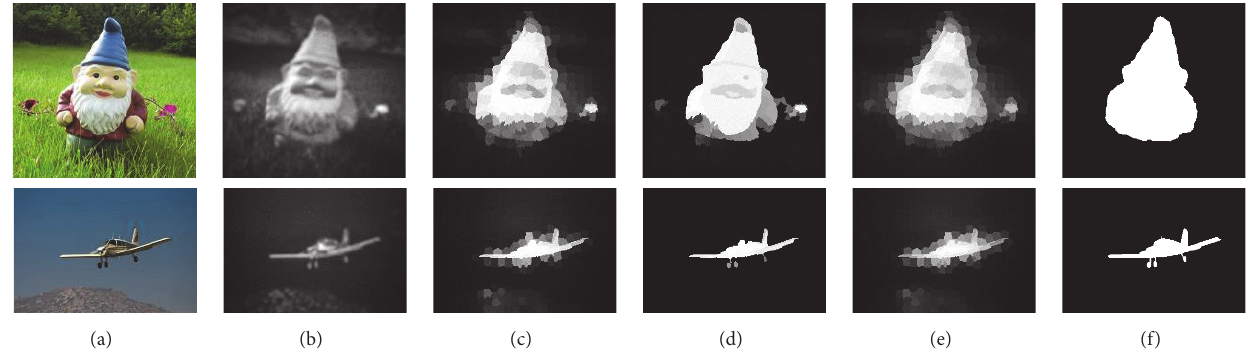
Figure 4: Geodesic distance refinement and comparison with Euclidean distance refinement. (a) Input image. (b) Coarse saliency map. (c) Saliency map after edge-preserving element-level filtering. (d) Saliency map using geodesic distance refinement. (e) Saliency map using Euclidean distance refinement. (f) Ground